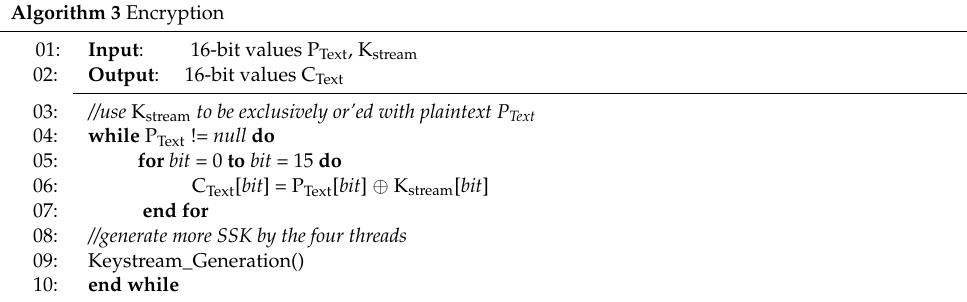
Algorithm 3 Encryption